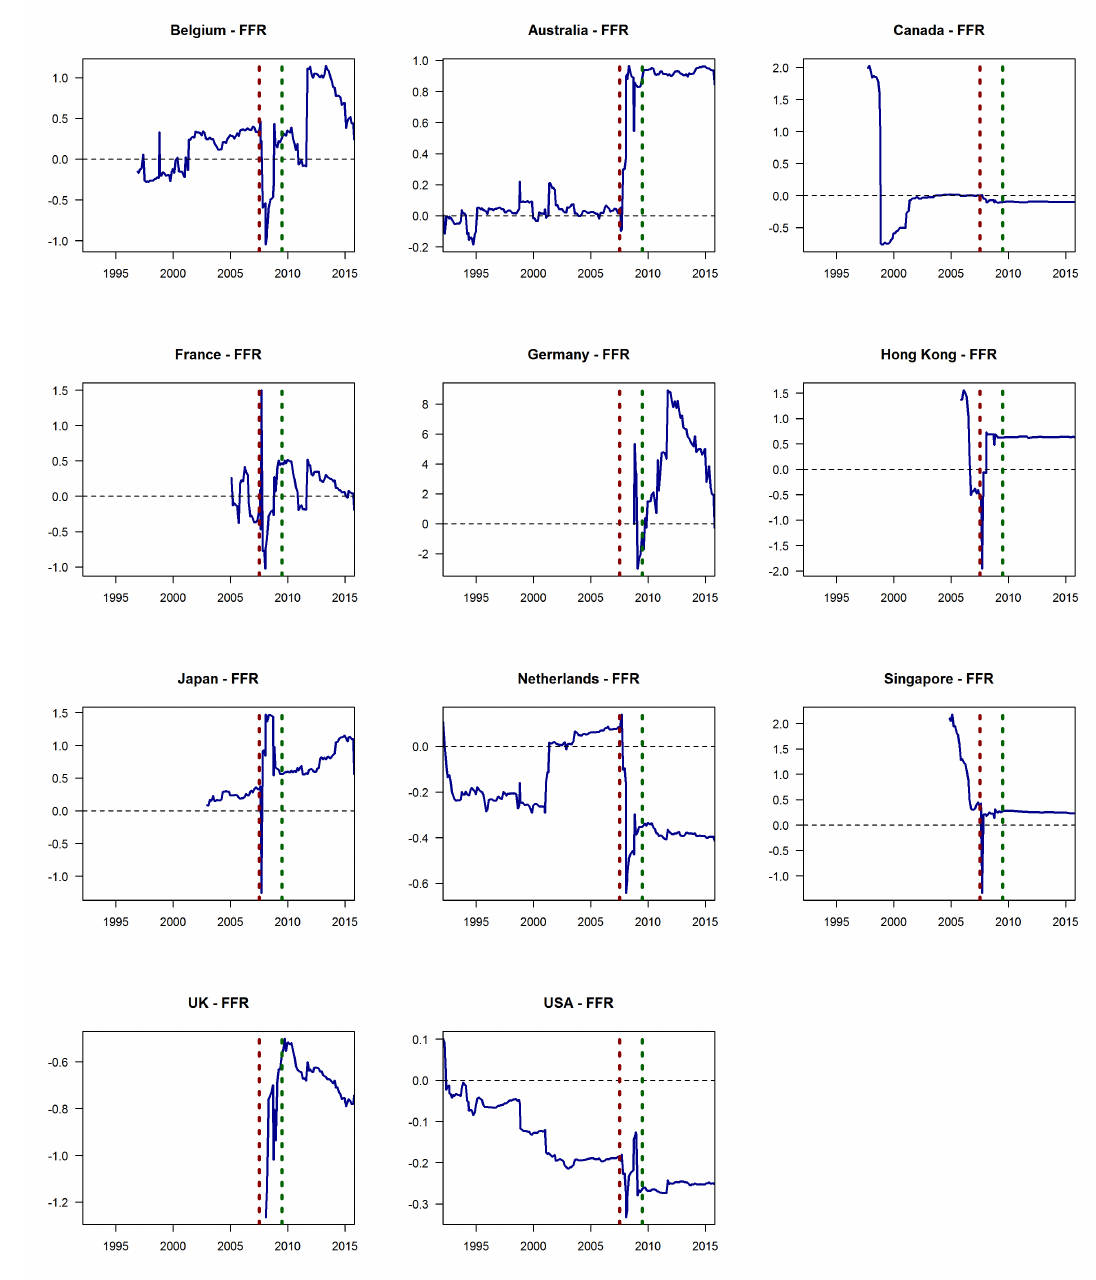
Figure 1. Time-varying impact of federal funds rate shocks. The plots show the time-varying response of international REITs to federal funds rate shocks. The period between the two vertical dotted lines capture the period of global financial